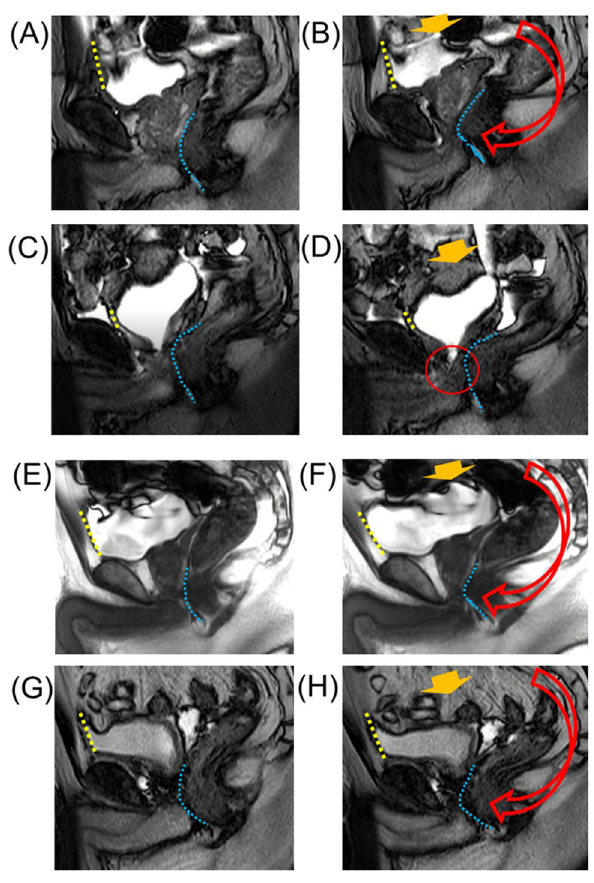
Figure 2. Dynamic mid-sagittal magnetic resonance imaging (MRI) of conventional robot-assisted radical prostatectomy (RARP): preoperatively at rest ( A ), preoperatively with abdominal pressure ( B ), postoperatively at rest ( C ), and postoperatively with abdominal pressure ( D ). Dynamic mid-sagittal MRI of Retzius-sparing RARP: preoperatively at rest ( E ), preoperatively with abdominal pressure ( F ), postoperatively at rest ( G ), and postoperatively with abdominal pressure ( H ). Yellow dashed line: attachment between the anterior bladder wall and the abdominal wall. Blue dashed line: the anterior wall of the rectum. ( B , F ) When applying abdominal pressure (orange arrow), the bladder is compressed caudally. At the same time, the pelvic organs are rotated forward (red arrow) with the anterior wall of the bladder (yellow dashed line) attached to the abdominal wall as a fulcrum, and the membranous urethra is compressed forward (blue dashed line). ( C ) The attachment of the anterior wall of the bladder moving caudally. ( D ) When applying abdominal pressure (orange arrow), the bladder is compressed caudally, the bladder neck is enlarged (red circle), and urinary incontinence is observed. ( H ) When applying abdominal pressure (orange arrow), the bladder is compressed caudally. At the same time, the pelvic organs are rotated forward (red arrow) with the anterior wall of the bladder (yellow dashed line) attached to the abdominal wall as a fulcrum, and the membranous urethra is compressed forward (blue dashed